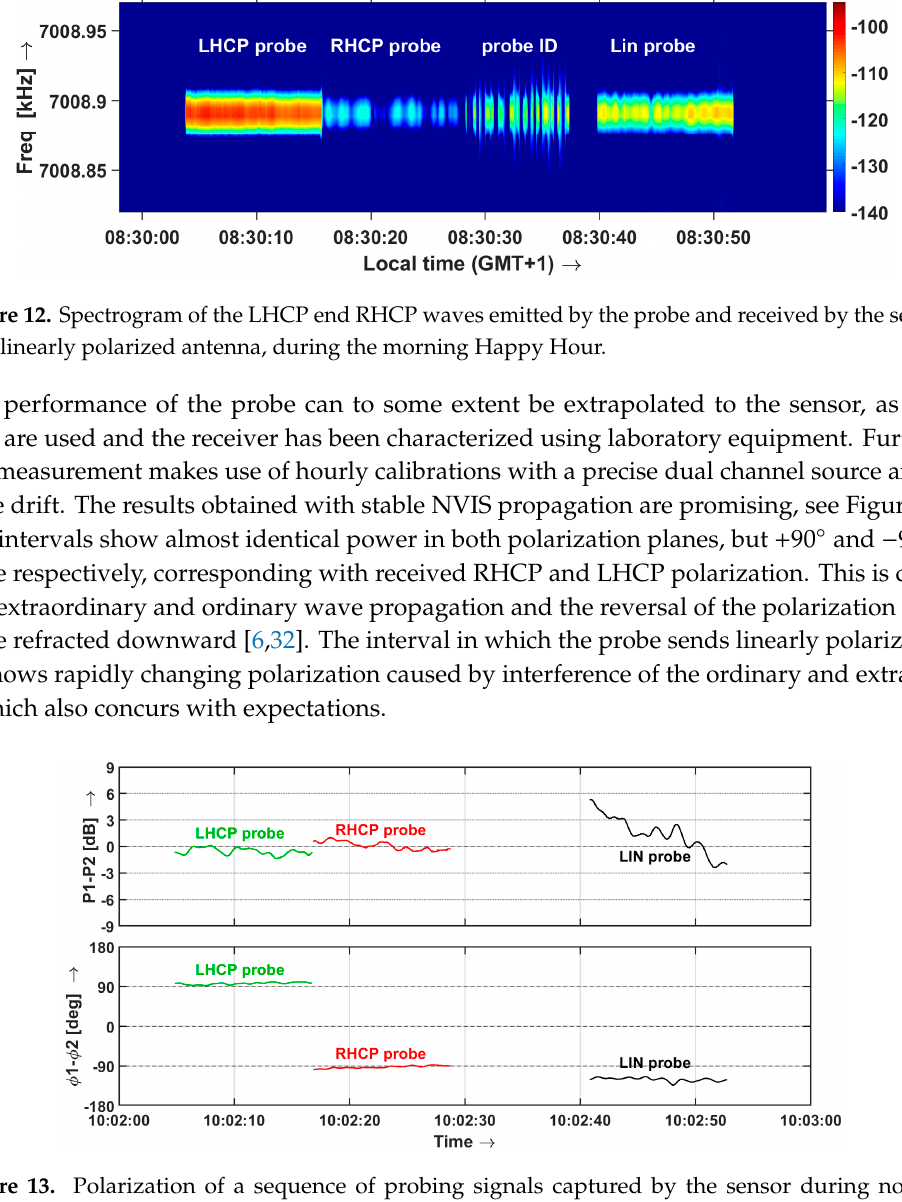
Figure 11. Spectrogram of the LHCP end RHCP waves emitted by the probe and received by the sensor on a linearly polarized antenna, during normal NVIS propagation.